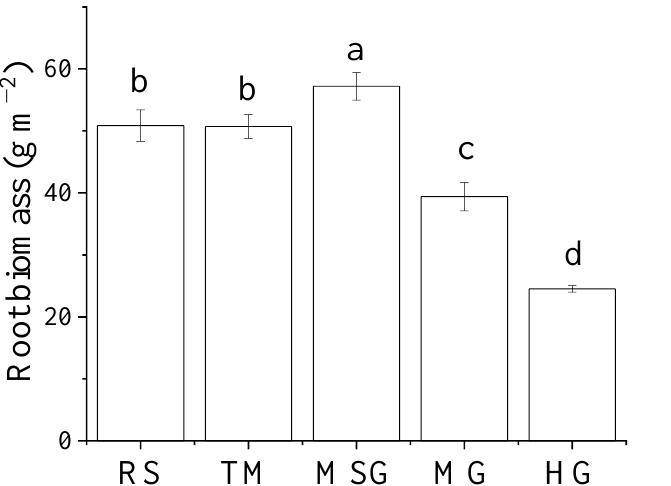
Figure 2. Root biomass of plants in wetlands under different land uses. Different letters indicate significant differences among five wetlands ( p < 0.05).